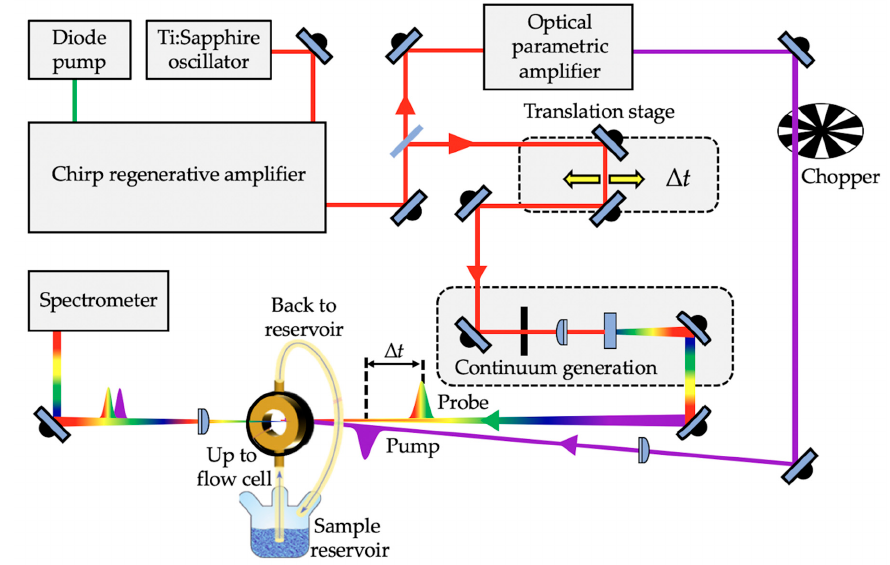
Figure 2. Scheme showing a typical transient electronic absorption spectroscopy (TEAS) experimental